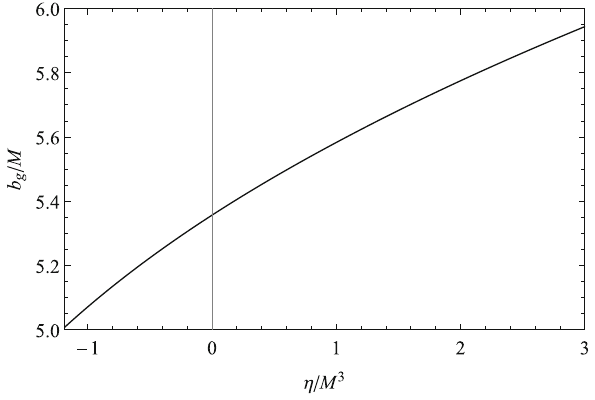
Fig. 6 Gloryimpactparameterasafunctionofthedeformationparam- eter